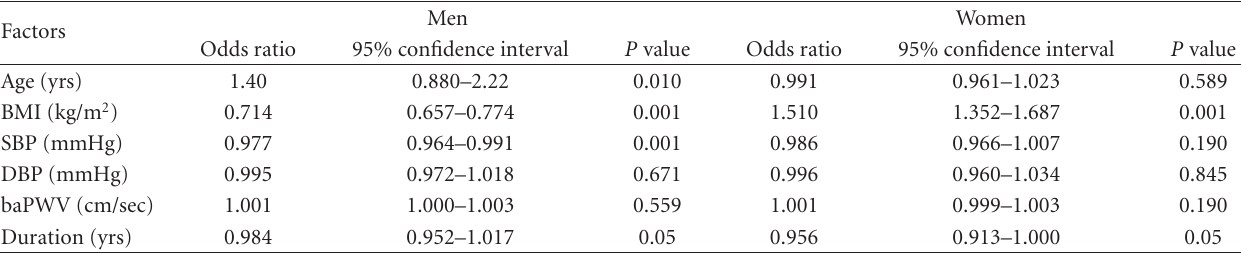
Table 5: Multiple logistic regression analysis of various clinical factors and ankle-brachial pressure index